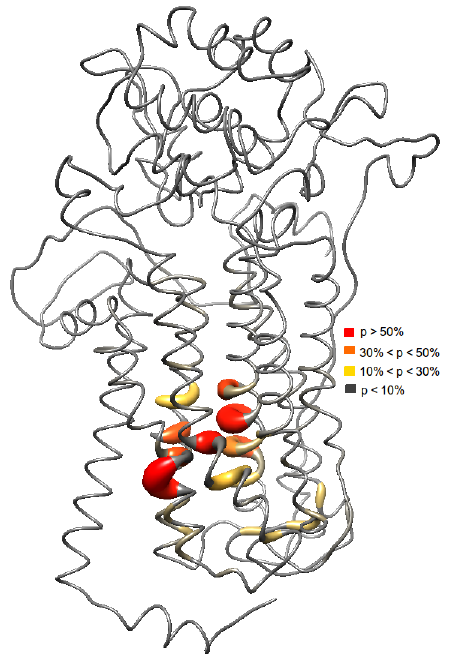
Figure 3. Different binding sites were observed from the ensemble docking since the ensemble is a collection of different conformations of the protein. Here, probability (p) of the ligands to interact with several residues is